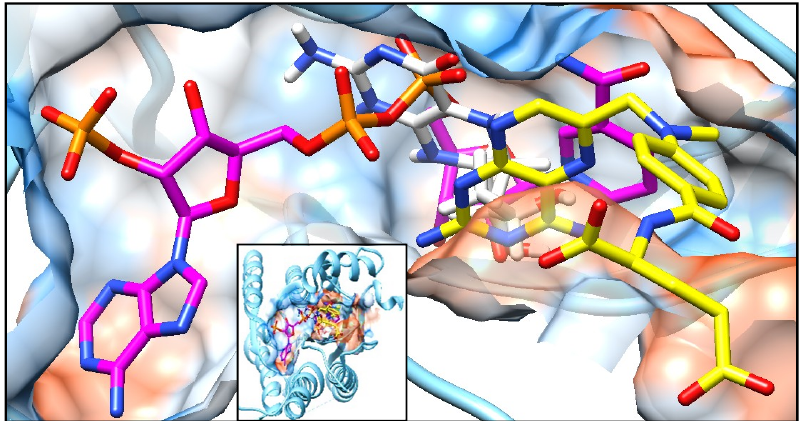
Figure A3. Complex of PTR1 (PDB ID: 1E7W) with three physiological ligands: NADP (magenta), MTX (yellow) and THB (white). Small box, total vision, and big box, augmented vision of the protein surface in transparency style of USCF Chimera program.